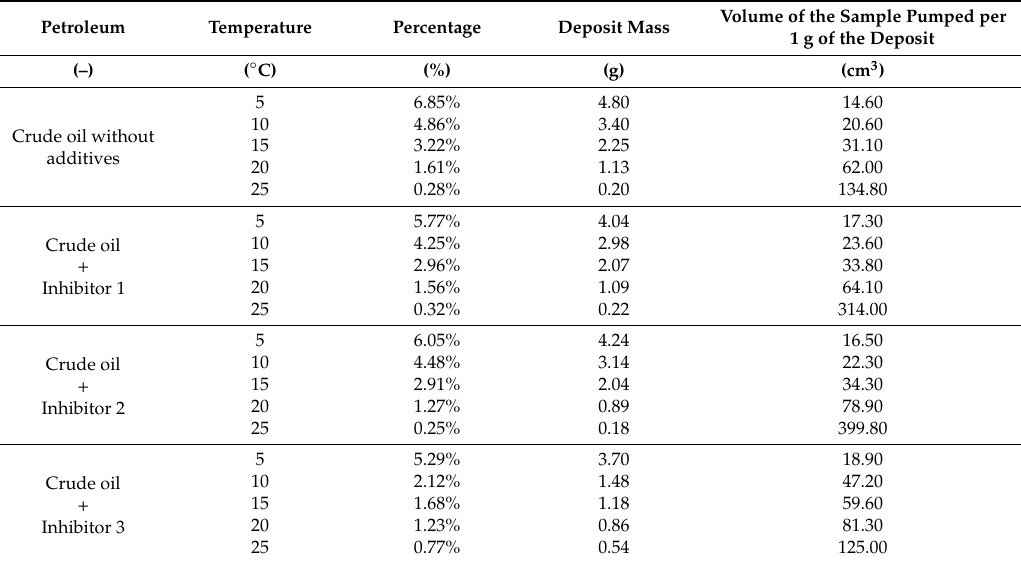
Table 8. Results of testing wax formation tendency as the temperature